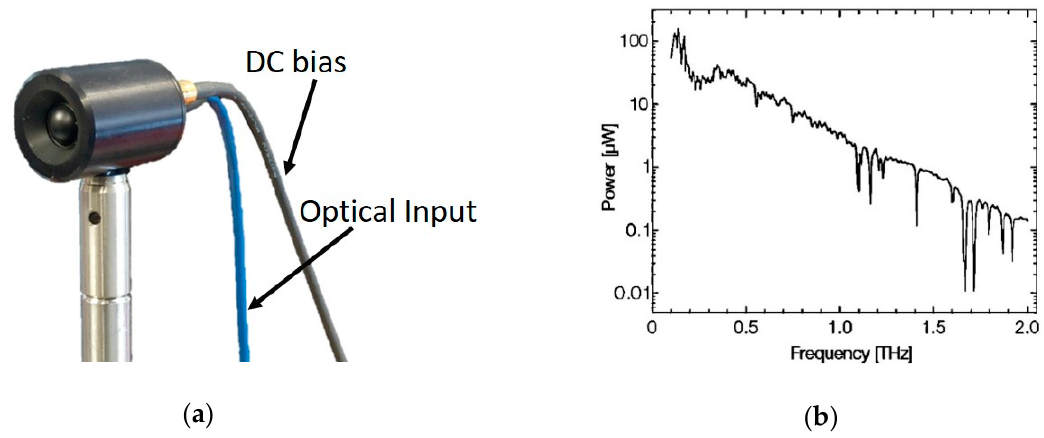
Figure 1. The millimeter-wave (MMW) generator and transmitter. ( a ) An InGaAs p-i-n photomixer module. ( b ) Output power spectrum of the photomixer [15].